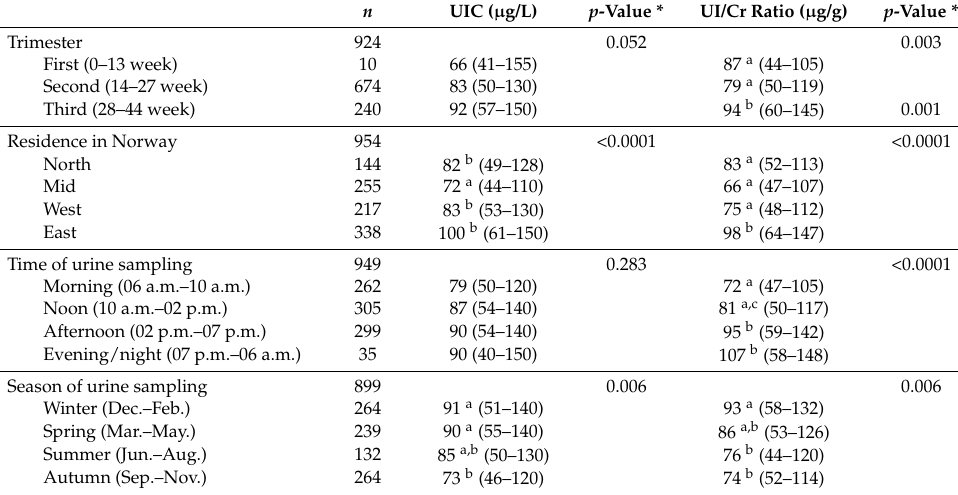
Table 2. Urinary iodine concentration ( µ g/L (UIC)) and urinary iodine to creatinine ratio ( µ g iodine/g creatinine (UI/Cr ratio)) according to maternal sample collection characteristics given as median with 25th and 75th percentiles in the study population.